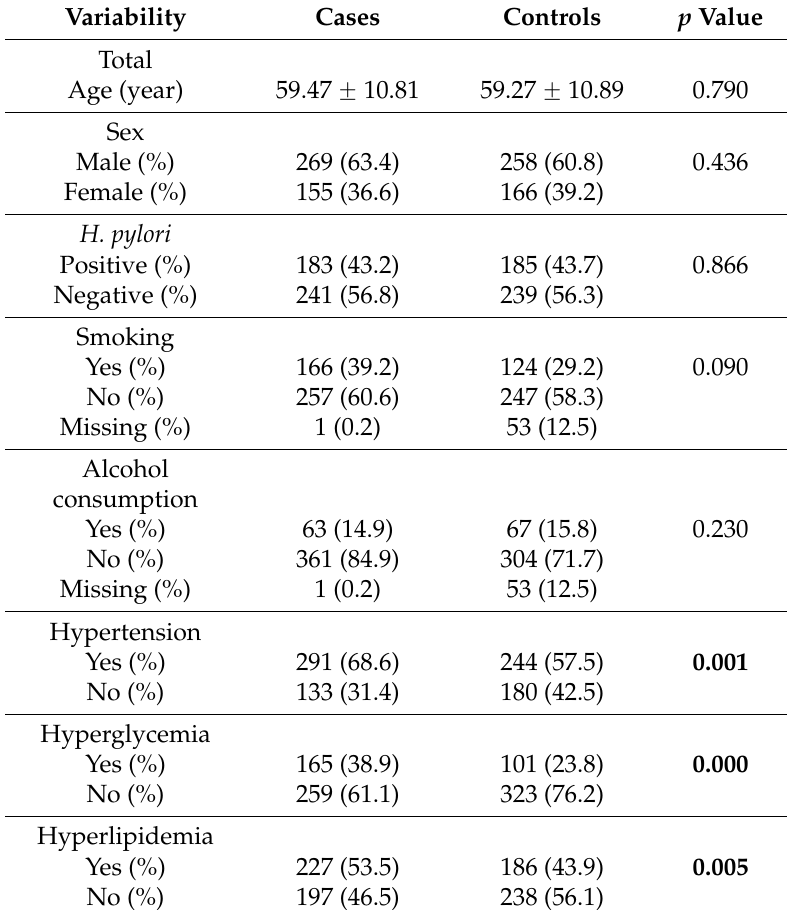
Table 1. Baseline characteristics of the study